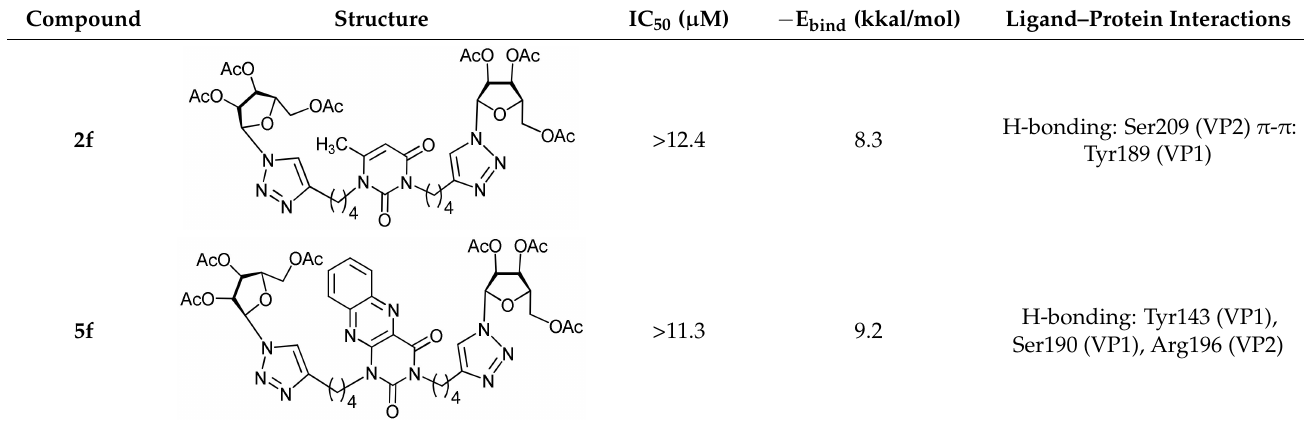
Table 5. Inhibitory activity against Coxsackievirus B3 of the lead compounds as well as their binding energies and ligand-protein interactions obtained via molecular docking simulations.